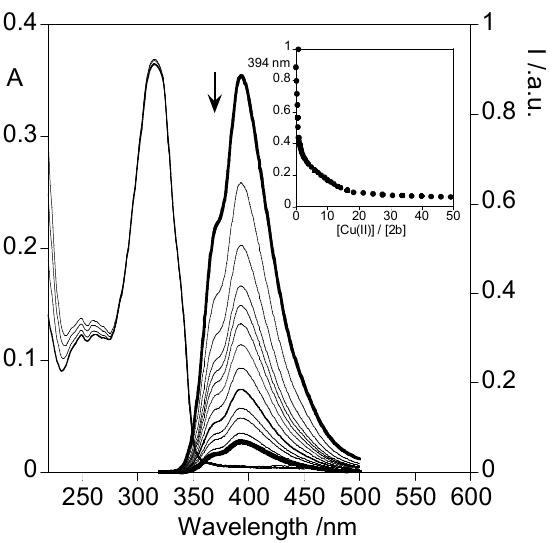
Figure 2. Spectrophotometric titration and fluorimetric titration of an ethanolic solution of 2b with a standard solution of Cu(CF